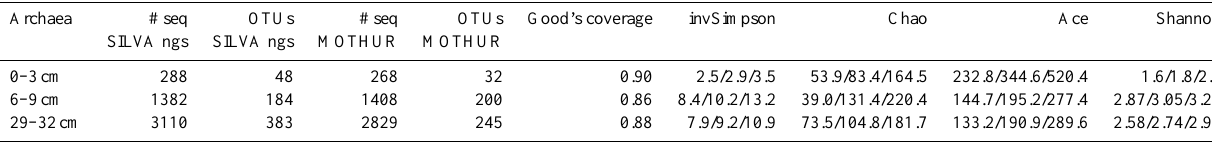
Table 2. Archaeal sequences used for classification in SILVA ngs and for subsample in MOTHUR for the alpha diversity. Archaea # seq